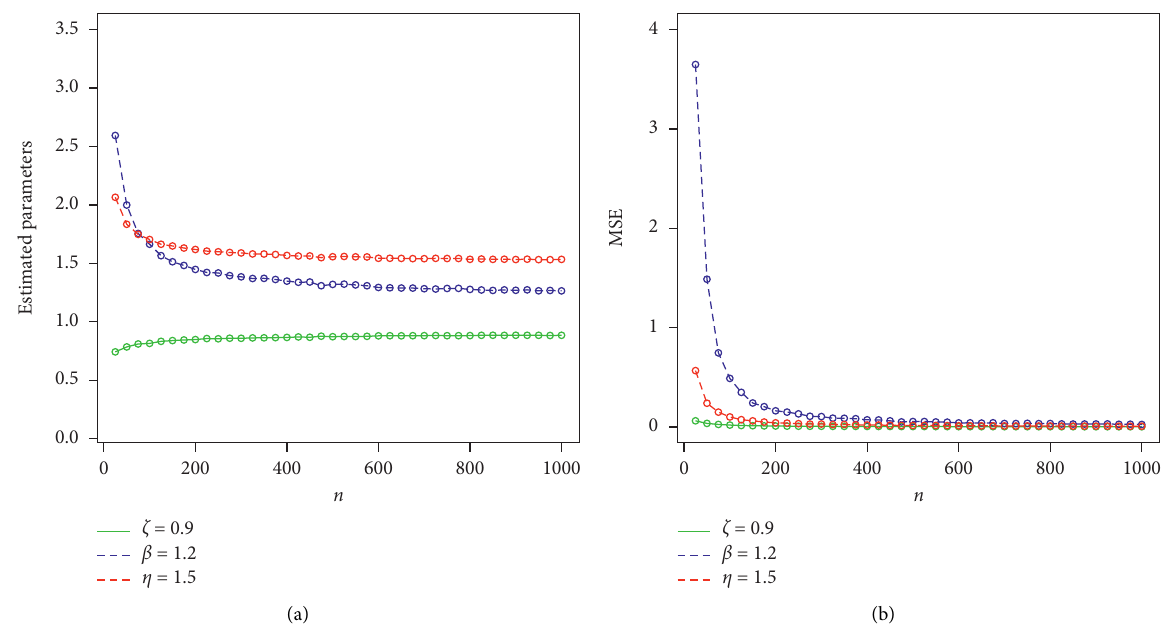
Figure 6: Graphical display of the simulation results provided in Table 1. (a) Plot of estimated parameters vs. n . (b) Plot of MSEs vs.